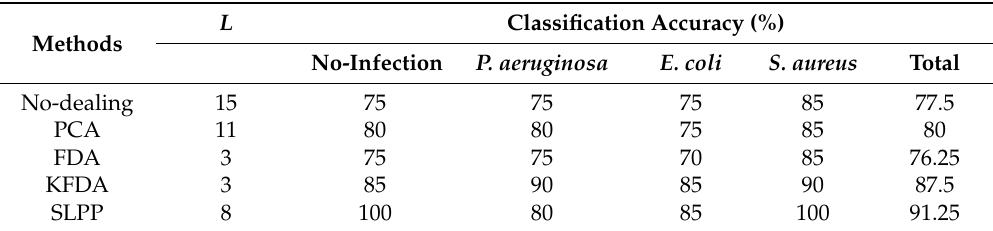
Table 9. Classification results of 80-fold using different processing methods